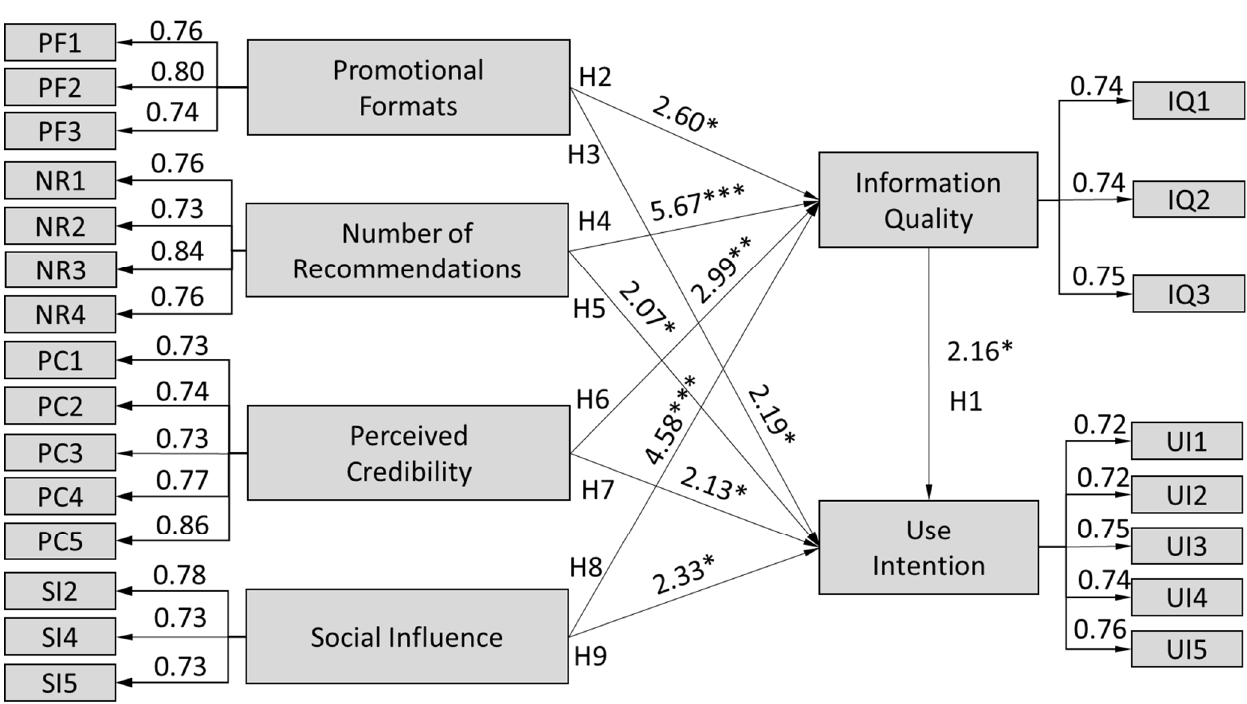
Figure 2. Results of path analysis. Notes: Significance of path coefficients: * p < 0.05, ** p < 0.01, *** p <